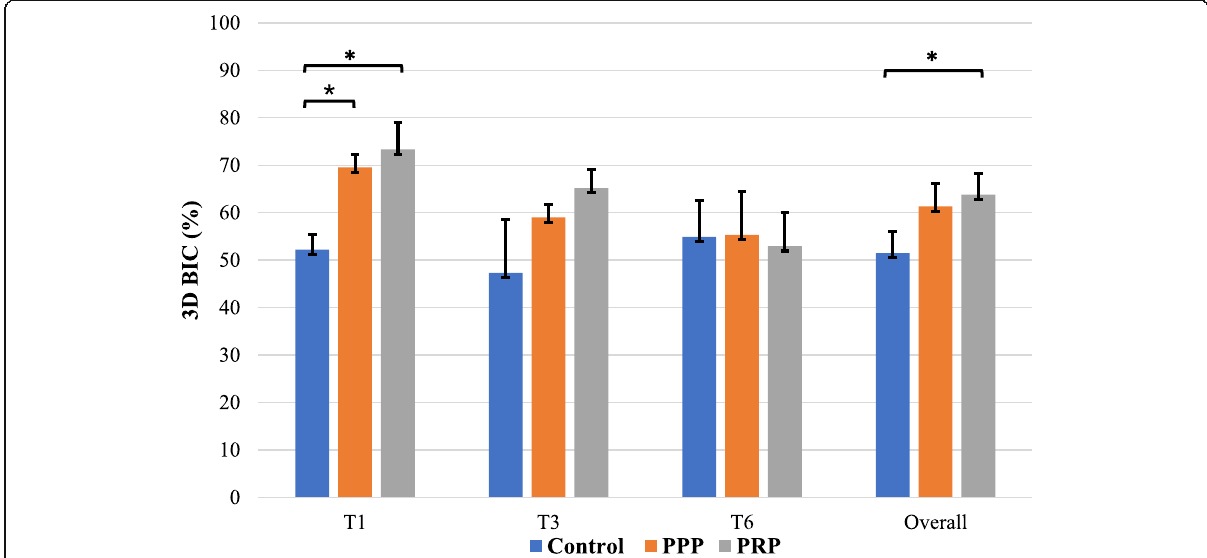
Fig. 3 Impact of PRP and PPP on 3-demension bone-implant-contact ratio (3D BIC%) at individual time-points and overall influence irrespective of time. PPP, platelet-poor plasma; PRP, platelet-rich plasma; T1, 1 month; T3, 3 months; T6, 6 months. * p < 0.05 statistically